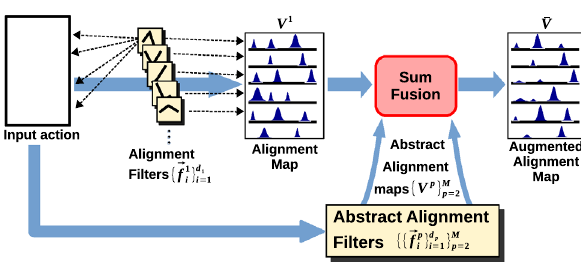
Fig. 2 Alignment layer of the network. Each Al-filter 𝐟 1 all n f channels in the input to form the i -th row in the alignment map 𝐕 1 . Adding 𝐕 1 to the alignment maps of other Abs-filters derives the ̄ 𝐕 augmented map